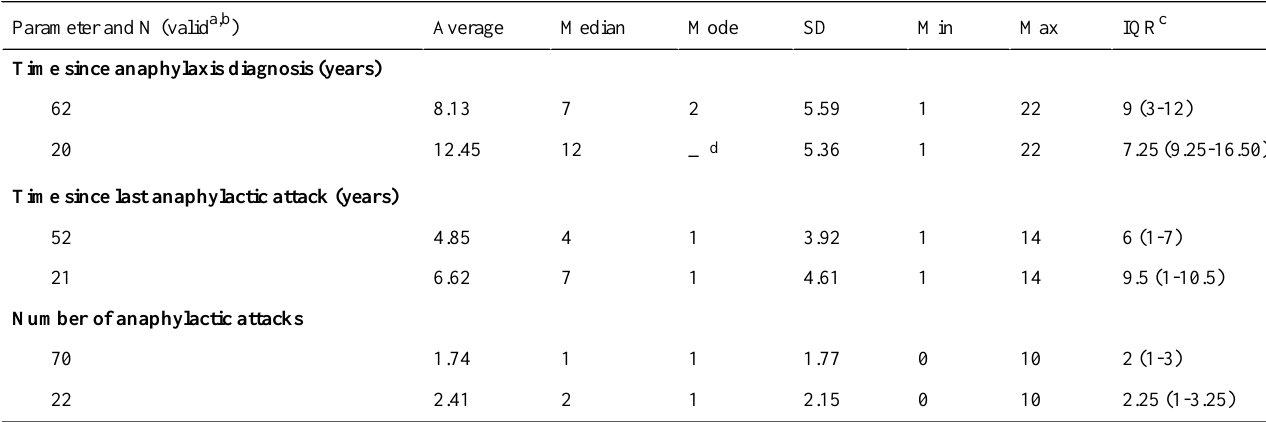
Table 4. Medical statistics of children.